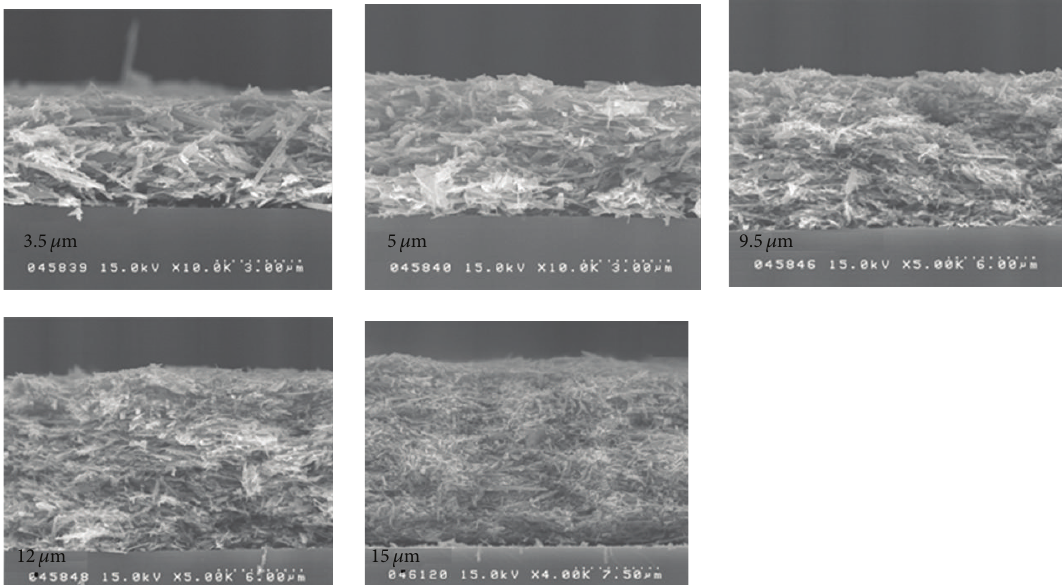
Figure 6: The cross-section scanning electron microscopy (SEM) images of TiO 2 thin films with different thicknesses.